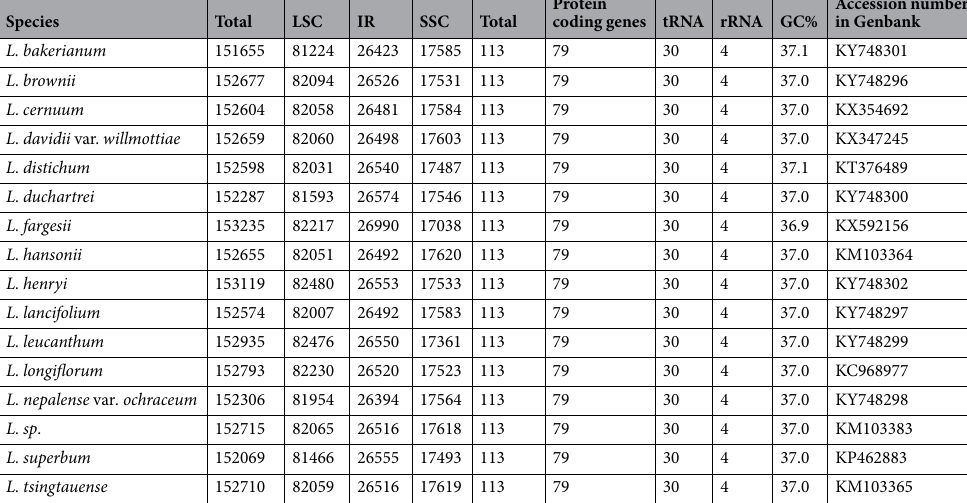
Table 2. Summary of complete chloroplast genomes of Lilium